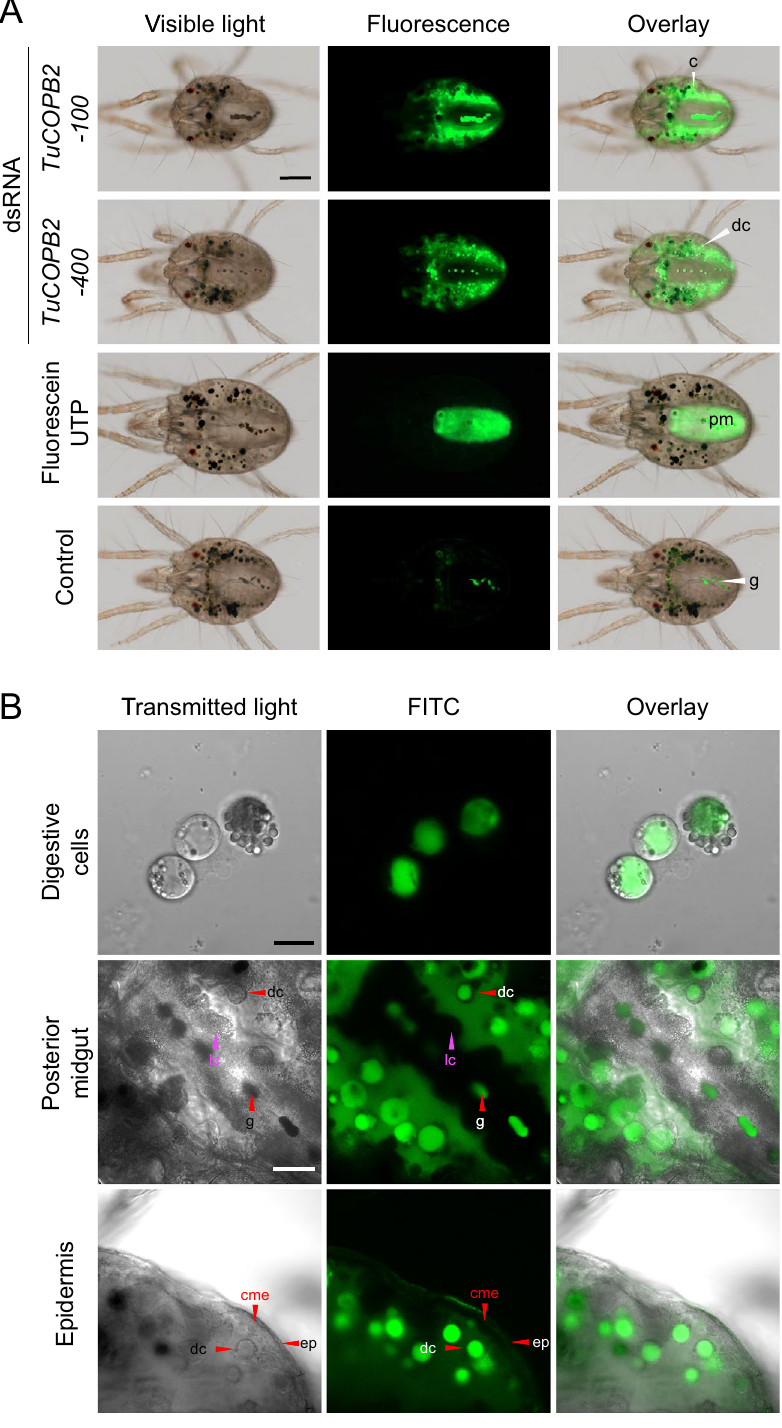
Figure 3. Localization of the ingested fluorescently labelled dsRNAs- TuCOPB2 -100 and dsRNAs- TuCOPB2 -400 following 24 h of mite feeding. ( A ) Fluorescence of labeled dsRNAs is seen in the mite caeca lumen (c) and digestive cells (dc); free fluorescein-12-UTP localizes in the posterior midgut (pm); guanine pellets (g), located in the posterior midgut, exhibit autofluorescence. ( B ) A close-up of fluorescently labelled dsRNAs in digestive cells, posterior midgut, and epidermis. caecal midgut epithelium (cme); large cell (lc); epidermis (ep). Scale bar: (A) 100 μm; (B) 10 μm for the digestive cells panels and 25 μm for the posterior midgut and epidermis